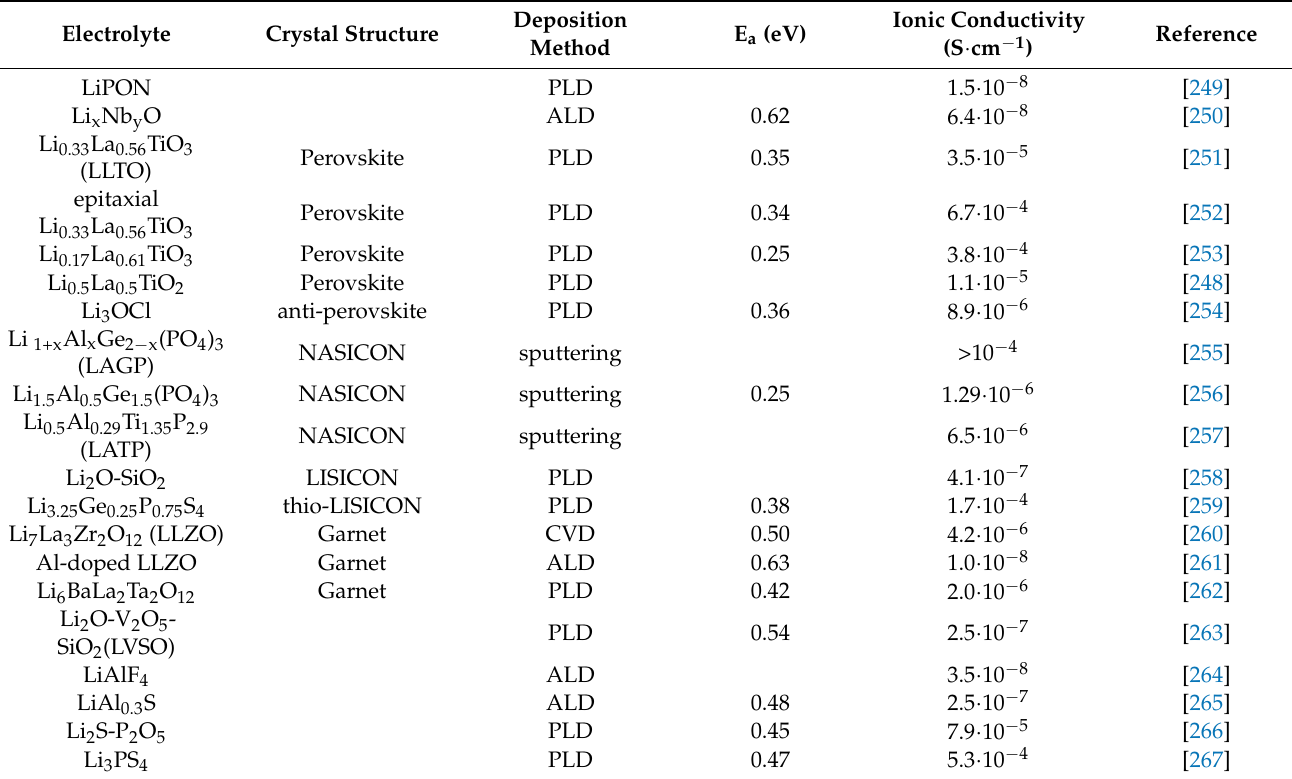
Table 4. Various solid electrolyte materials for